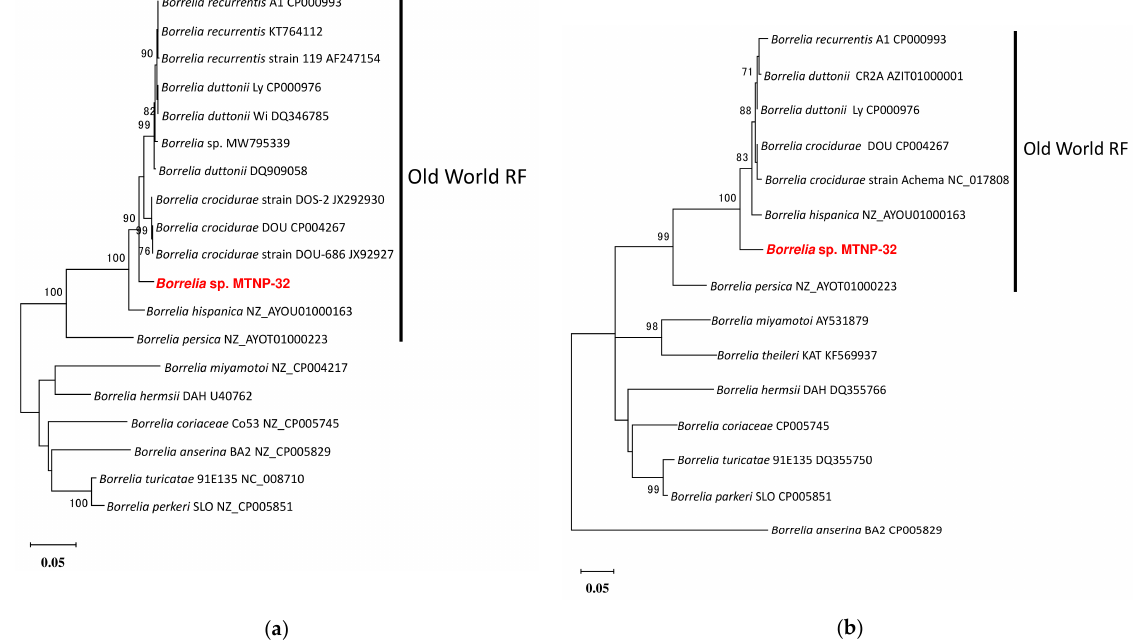
Figure 4. Phylogenetic trees of Borrelia sp. from MTNP-32. The analyses were performed by the ML method with the Kimura-2 parameter. Bootstrap values > 70% are based on 1000 replications and are shown beside the branches. ( a ) The tree based on 840 bp of the glpQ sequence; ( b ) the tree based on 388 bp of the hpt sequence. The sample in this study is in bold and red.